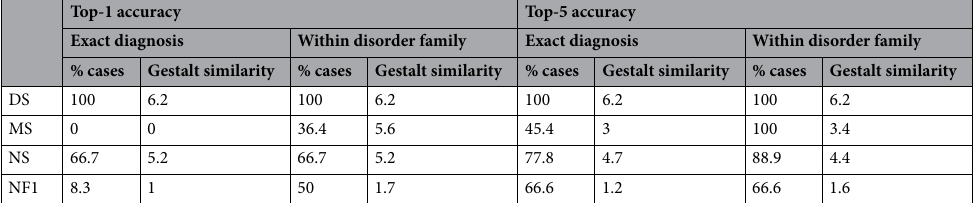
Table 2. Accuracy of Face2Gene diagnosis based on 2D facial images in Down, Morquio, Noonan and Neurofibromatosis type 1 syndromes in a Colombian population. Percentage of cases matching the genetic diagnosis are provided for each syndrome, as well as gestalt similarity values.